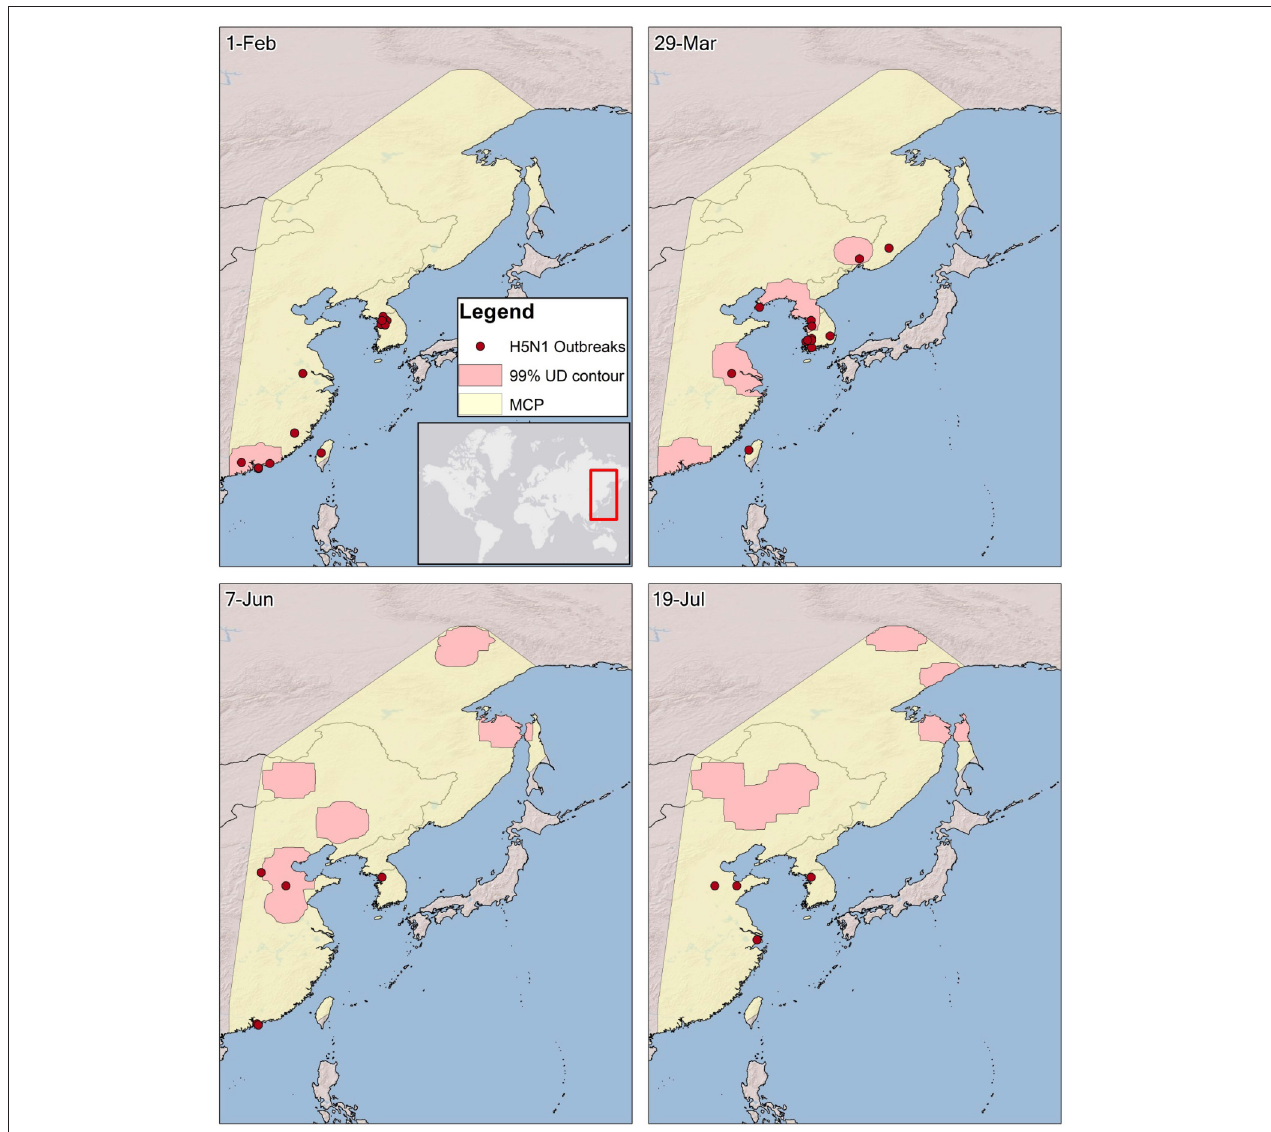
FIGURE 4 | The spatio-temporal association between H5N1 outbreaks and Eurasian wigeon during spring migration from Hong Kong. The 99% utilization distribution (UD) contour, representing bird locations during a 14-day period beginning on a date was derived from a kernel density averaging individual UDs for each bird per time period. A 99% minimum convex polygon (MCP) was created to delineate a domain for outbreaks within the flyway. Areas for both the contours and MCP over the open ocean and bays were removed since outbreaks would not occur in these areas. Outbreaks were grouped on a 7-day lag from bird locations to allow for incubation and onset of symptoms after a bird is